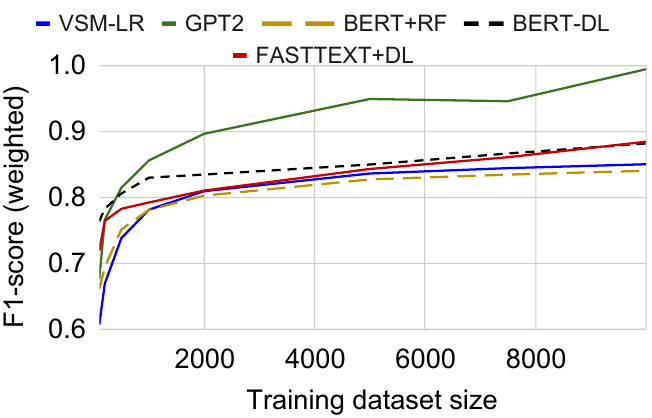
Figure 7. Classification performance (weighted F1-score) for the different combinations of language model and